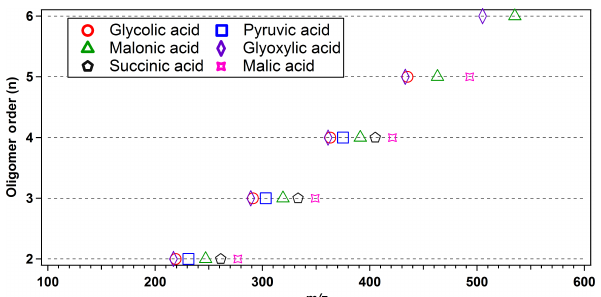
Figure 5. Order of oligomer ( n ) corresponding to the number of methylglyoxal (C 3 H 4 O 2 ) additions ( (cid:49)m/z = 72.02113) to spe- cific parent organic acids (listed in the legend), proposed to form through aqueous processing and measured in cloud water during the wildfire-influenced period (C1–C3). Compound identification was based on comparison of elemental formulas calculated from ( − ) ESI-FTICR-MS data with the oligomeric series previously re- ported by Altieri et al. (2008) from the aqueous reactions of methyl- glyoxal and